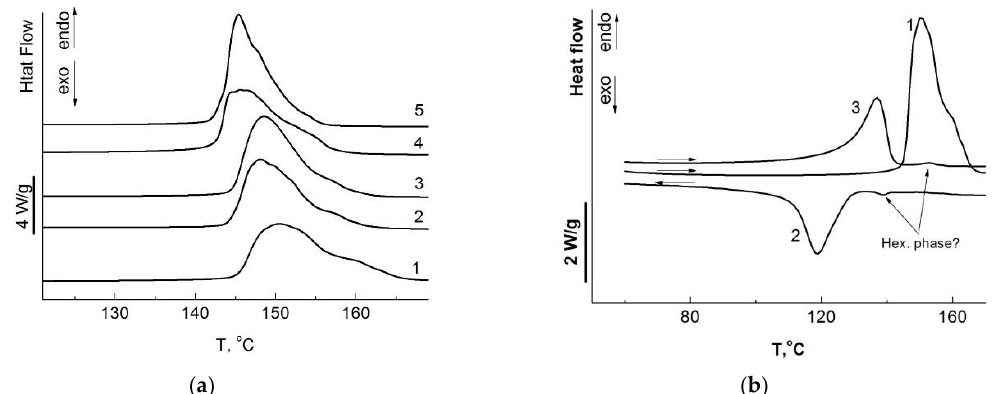
Figure 4. ( a ) DSC traces for UHMWPE films obtained from reactor powders synthesized at 10 (1), 22 (2), 30 (3), 40 (4), and 70 °C (5) on first heating at a heating rate 10 °C/min in argon; ( b ) DSC traces for UHMWPE films obtained from reactor powders synthesized at 10 °C on first heating (1), cooling (2), and reheating (3) at a heating/cooling rate ±10 °C/min in argon.